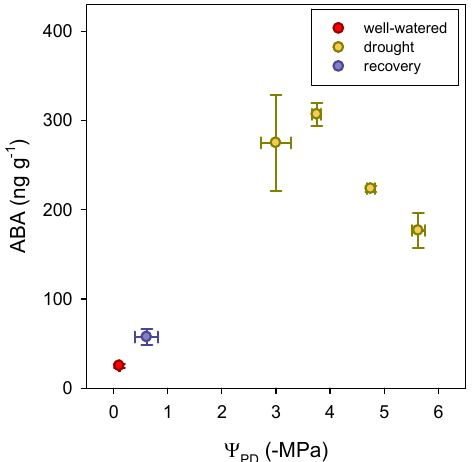
Figure 6. Time course of abscisic acid (ABA, ng g − 1 ) with predawn water potential ( ψ PD ) for well ‐ watered holm oak leaves (red symbols) during the drought period (yellow symbols) and 7 days after plants were re ‐ watered (violet symbols). Data are mean ± SE.